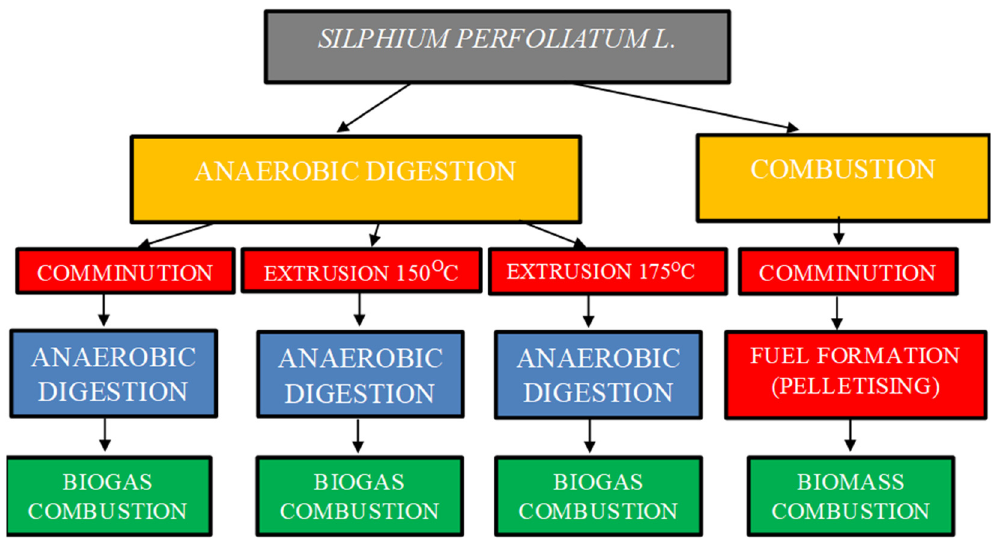
Figure 4. A diagram of the energy balance for various methods of handling cup plants ( Silphium perfoliatum L.). The processes requiring energy input are marked in red; the processes enabling energy production are marked in green.